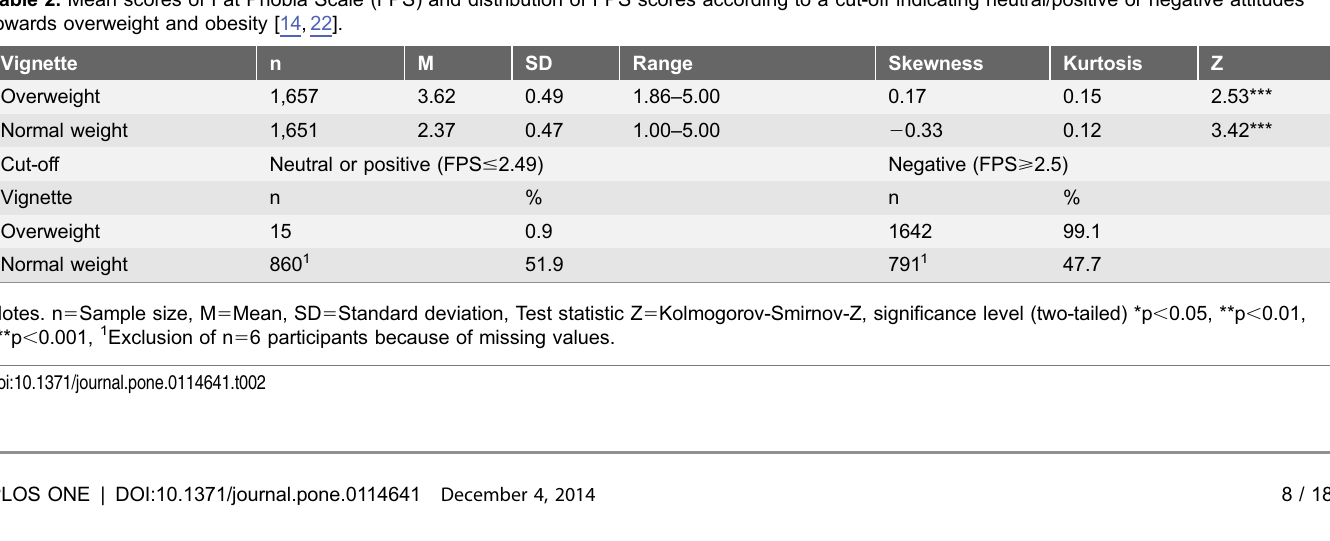
Cronbach’s a was determined as a measure for internal consistency and reliability of the FPS scale. For the total sample of 1,657 participants Cronbach’s a was 0.791 reflecting a moderate to good reliability of the FPS scale. In order to determine construct validity of the FPS, the correlations between the FPS score and other construct related scales, namely the Social Distance Scale (SDS), the scale for emotional reactions (SER) and the Perceived Devaluation and Discrimination Scale (PDD), were analyzed. Weak significant positive correlations were observed for the SER and the PDD scales (r 5 0.133, p , 0.001 and r 5 0.150, p , 0.001) but not for the SDS (r 52 0.045, p , 0.097). This means that a higher FPS score (and a higher level of negative attitudes towards obese individuals) was significantly associated with more negative affective/emotional reactions towards overweight or obese individuals as assessed by the SER scale and a stronger agreement with common prejudices of the general population towards obese individuals as assessed by the PDD scale.